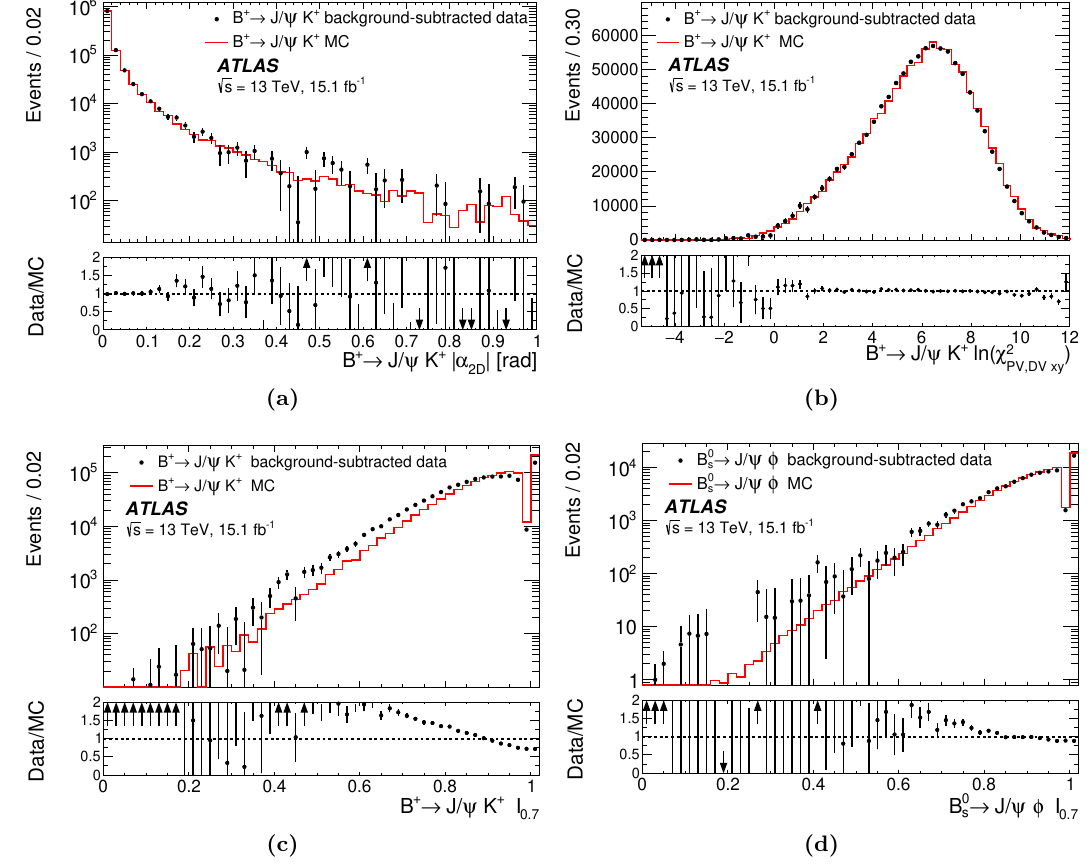
Figure 4. Data and MC distributions in B + ! J= K + events for the discriminating variables: (cid:0) (cid:1) (a) j (cid:11) 2D j , (b) ln (cid:31) 2 and (c) I 0 : 7 . The variable I 0 : 7 is also shown in (d) for B 0 PV ; DV xy events. The points correspond to the sideband-subtracted data, while the line corresponds to the MC distribution, normalised to the number of data events. The highest bin in (c) and (d) accounts for the events with I 0 : 7 = 1. The bottom insets report the data/MC ratio, zoomed-in in order to highlight discrepancies in the region that is most relevant for the